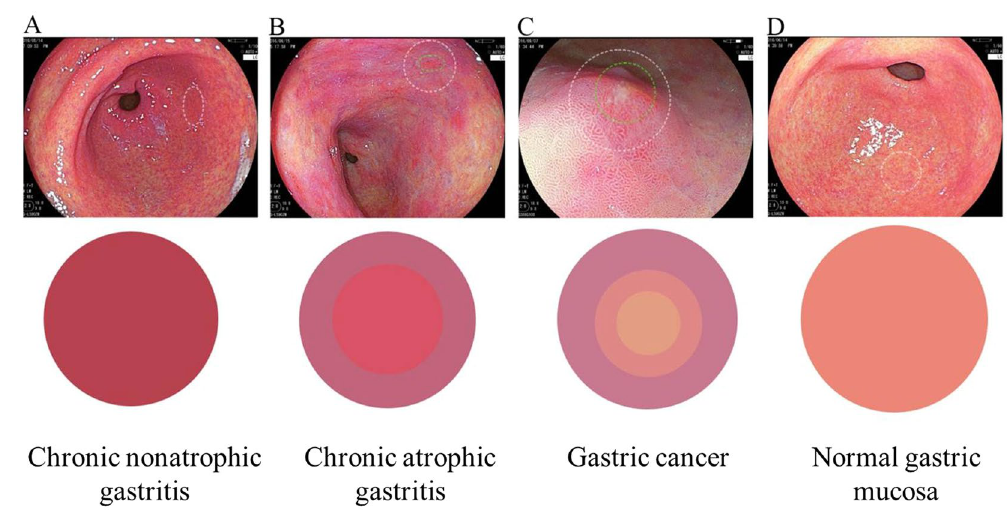
Figure 1. Colour types in the CMV criteria. ( A ) Colour type 1; ( B ) Colour type 2; ( C ) Colour type 3; ( D ) normal